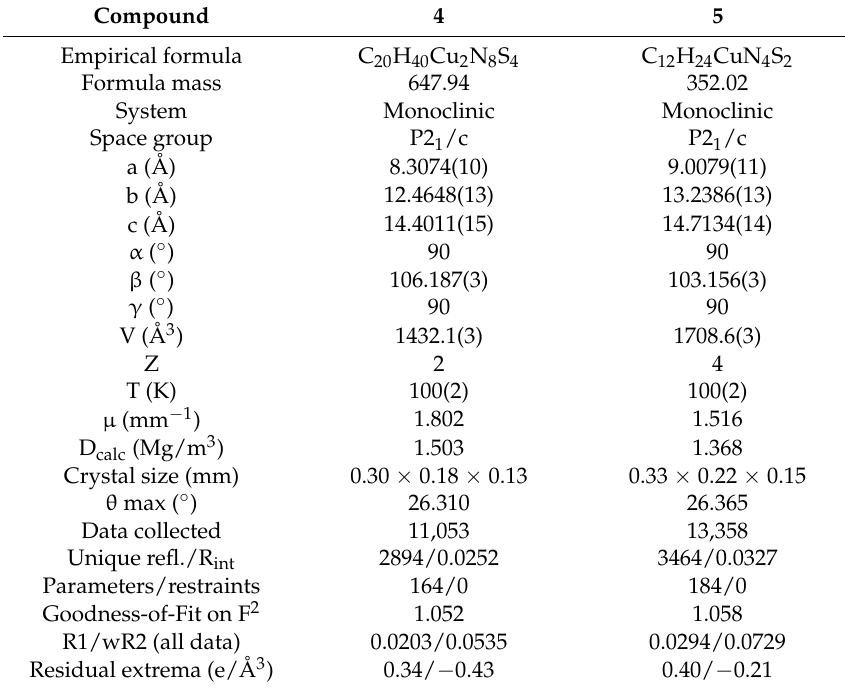
Table 5. Crystallographic data and processing parameters for 4 and 5